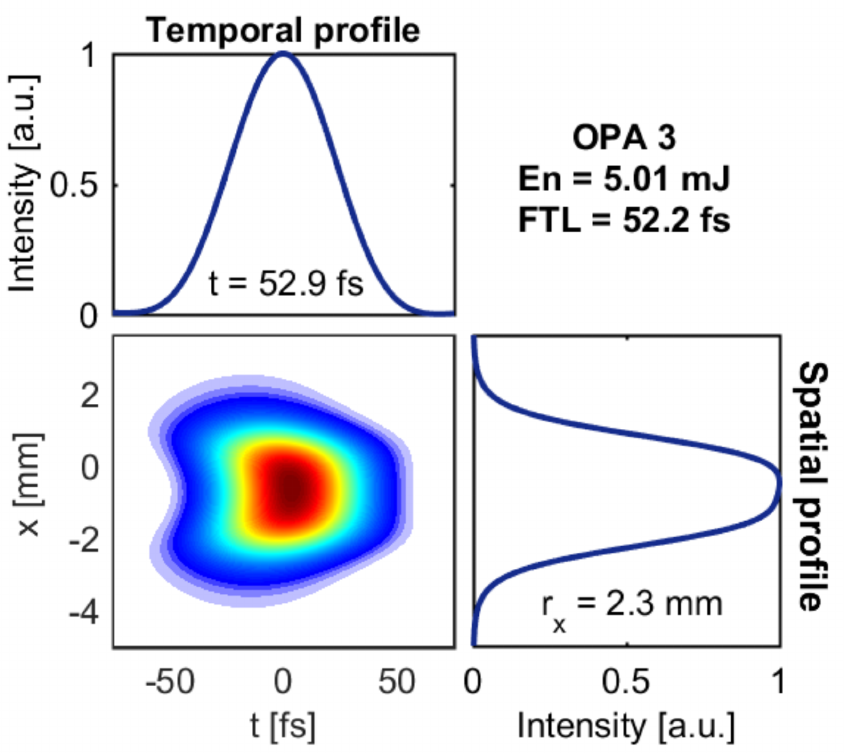
Figure 5. Spacetime profile of the optimized final output pulse from the hybrid OPCPA. The top and right lineouts represent the temporal and spatial profiles,